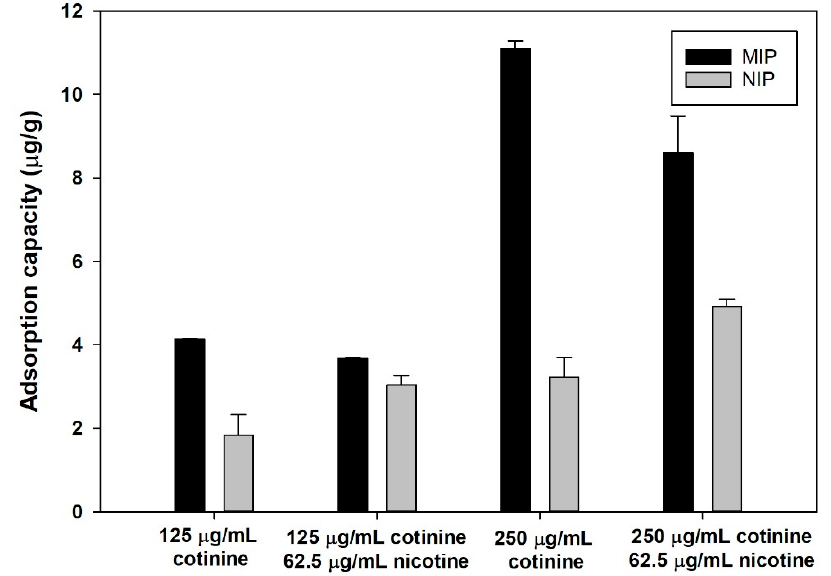
Figure 7. Interference study on adsorption capacity of MIP and NIP.